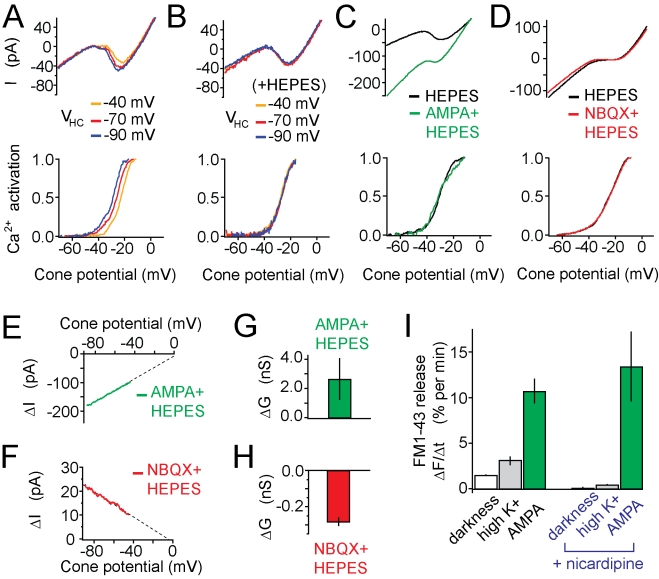
Ionic currents in cones modulated by negative and positive
feedback.(A) Changing the voltage of an HC (VHC) shifts the activation
of the voltage-gated Ca2+ current (ICa) in a
cone, indicative of negative feedback. Data for (A) and (B) were from
simultaneous patch clamp recordings from a synaptically connected HC and
a cone in a slice from salamander retina. Top: Current-voltage (I-V)
curves at three different values of VHC. Bottom:
ICa activation curves derived from these I-V curves (see
Methods). I-V curves were
generated by ramp depolarizations from −90 to 0 mV (0.5 mV/ms).
ICa activation curves were obtained by subtracting the
linear leak current from the total membrane current during the ramp. The
resulting leak-subtracted ICa was normalized to the maximal
ICa and plotted only over the voltage range where
channels are activating (e.g., from −70 to −20 mV). Data are
reported as mean ± SEM. (B) Same as (A), except with HEPES (10
mM) added to bath solution to block negative feedback. (C) AMPA (20
µM) elicits a voltage-independent conductance that increases with
hyperpolarization. HEPES (10 mM) was added to the bath solution to block
negative feedback. Traces represent average currents from five cones.
Data for panels (C–H) were from patch clamp recordings from cones
in flat-mounted salamander retinas. (D) NBQX (10 µM) reduces the
voltage-independent conductance. HEPES was again added to the bath
solution to block negative feedback. Traces represent average currents
from 13 cones. (E, F) I-V curve of the voltage-independent conductance
modulated by AMPA or NBQX. Difference currents were calculated from data
in panels (C) and (D). Dashed lines are extrapolated linear fits to show
reversal potentials. (G, H) Quantification of the average effect of AMPA
(n = 5) or NBQX
(n = 13) on the
voltage-independent conductance. (I) L-type Ca2+
channels are not required for positive feedback. Left: The FM1-43
release rate in darkness is accelerated by adding high
K+ (n = 9) or
20 µM AMPA (n = 16).
Addition of nicardipine (100 µM) suppressed release in darkness
(n = 7) and in high
K+ (n = 3) but
not in AMPA (n = 4).